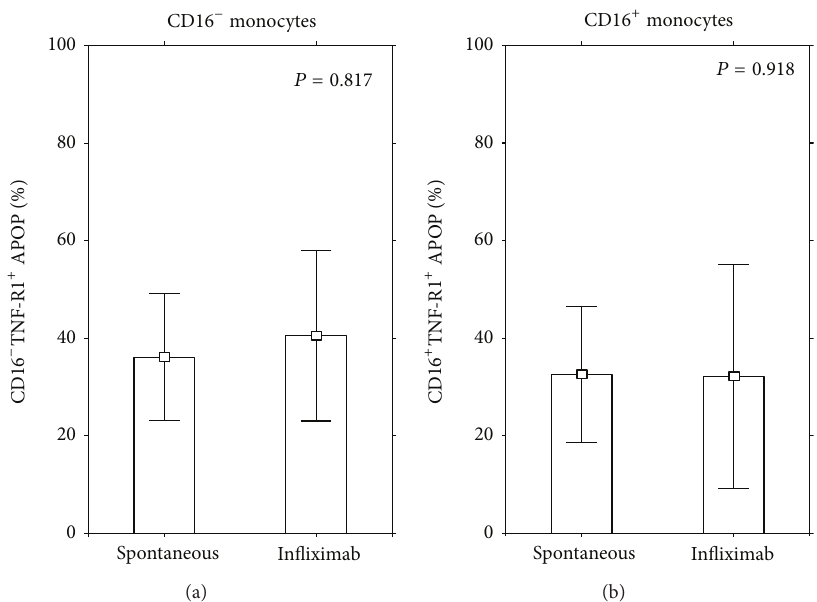
Figure 6: Effect of infliximab on apoptotic CD16 − and CD16 + TNF-R1 + monocytes in the healthy subjects. Peripheral blood mononuclear cells from 30 age- and sex-related healthy were incubated for 24 hours in a culture medium and then stained for visualization of the CD14, CD16, and TNF-R1 molecules. Next cellular pellet was incubated for further 15 minutes with fluorochrome-conjugated Annexin V to calculate the number of Annexin V-positive cells. The percentage of CD16 − and CD16 + TNF-R1 + apoptotic cells was summarized and presented as an arithmetic mean ± S.D. Statistical significance was calculated by means of the Kruskal-Wallis Anova